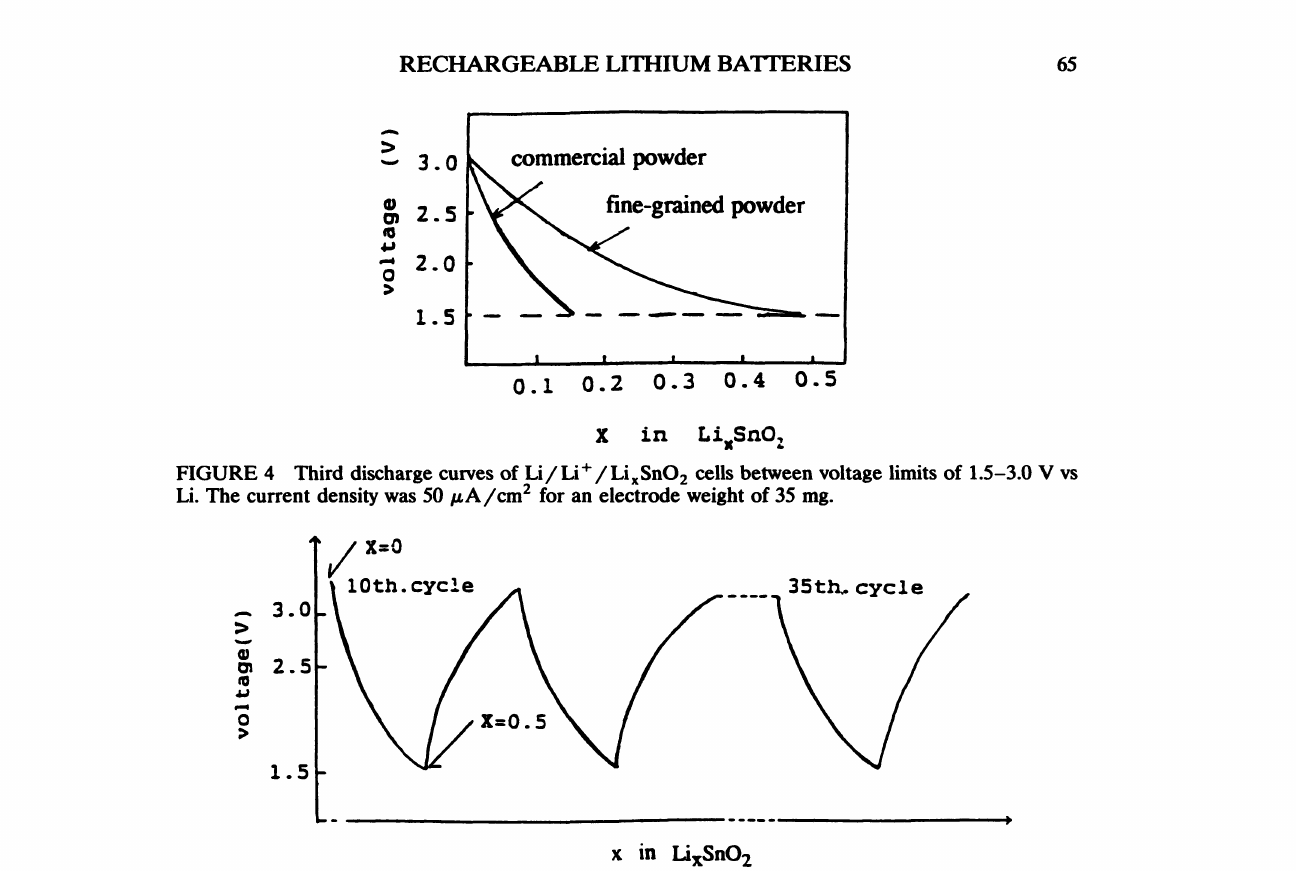
cells between voltage limits of 1.5-3.0 V vs 2